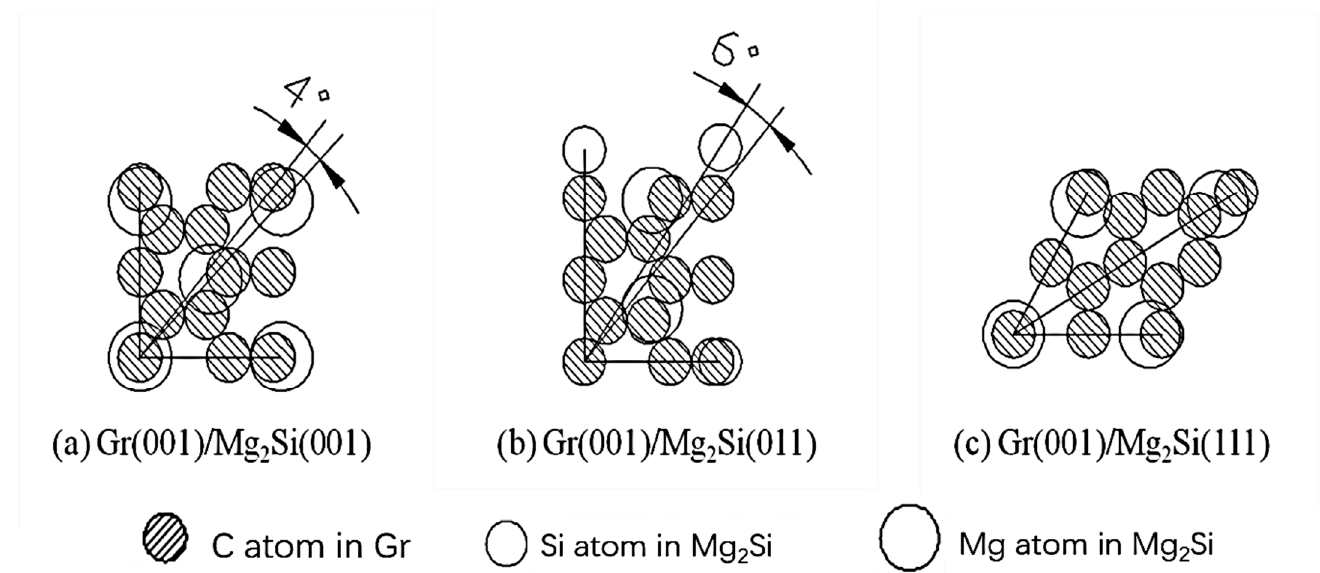
Figure 2. The potential orientation relationship between Gr and Mg 2 Si.